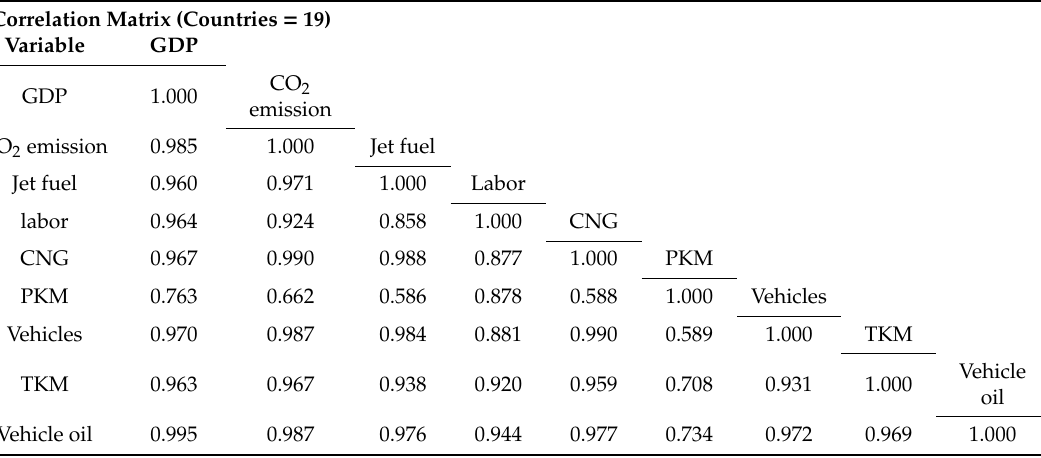
Table 5. Correlation matrix of the input and output